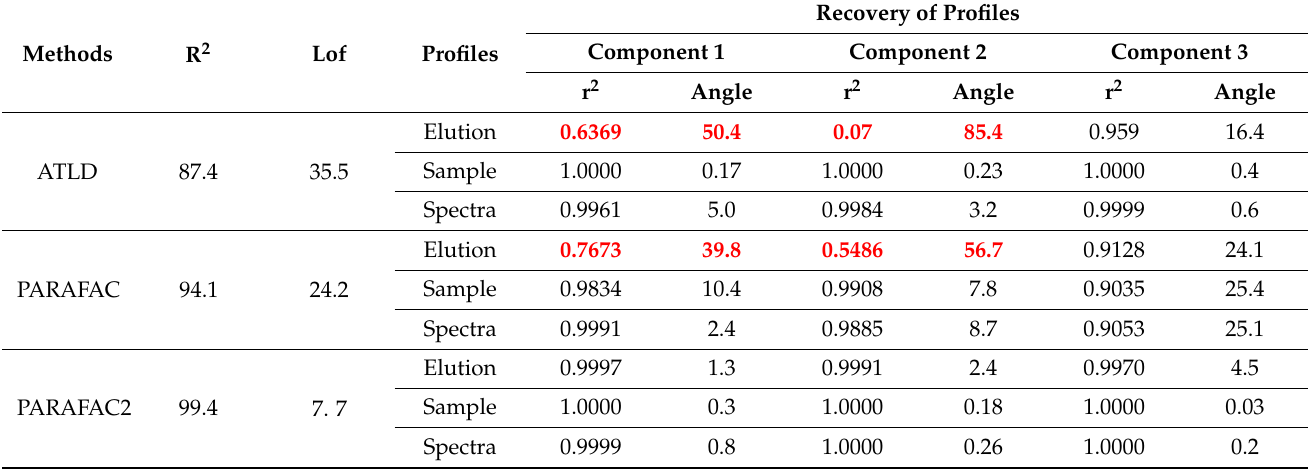
Table 1. Comparison of results obtained by ATLD, PARAFAC, PARAFAC2, DNTD and different variants of MCR-ALS in the analysis of the LC-DAD data set. In bold red are worse recovered profiles with r 2 values below 0.9. See Equations (7)–(10) for the meaning of R 2 , lof, r 2 and angle. See end of Section 2.2 for the meaning of the different MCR-ALS